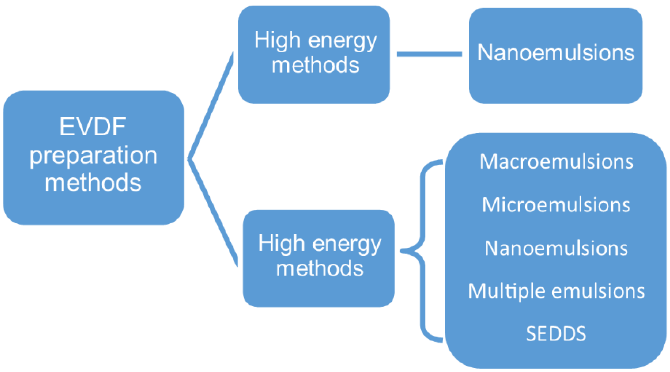
Figure 3. EVDF preparation methods.